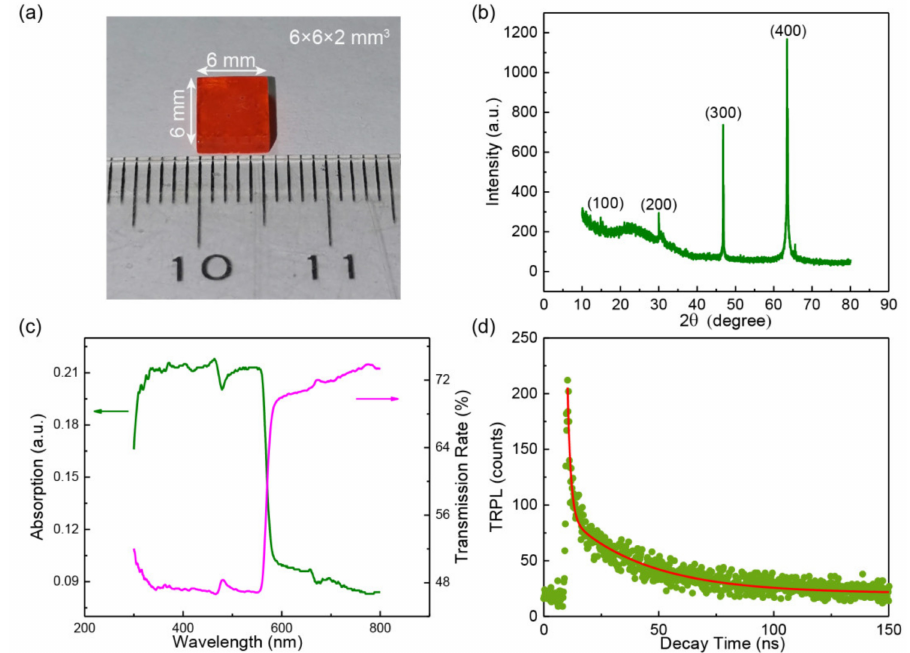
Figure 1. ( a ) Optical image of the as fabricated MAPbBr 3 single crystal (SC). ( b ) X-ray diffraction (XRD) pattern of the entire MAPbBr 3 SC. ( c ) Absorption and transmission rate spectra of the MAPbBr 3